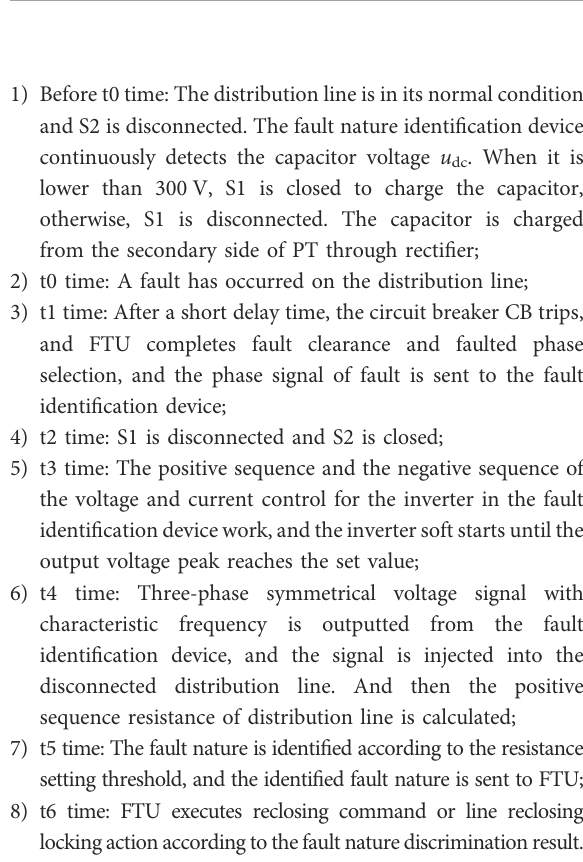
FIGURE 5 10 kV distribution system.